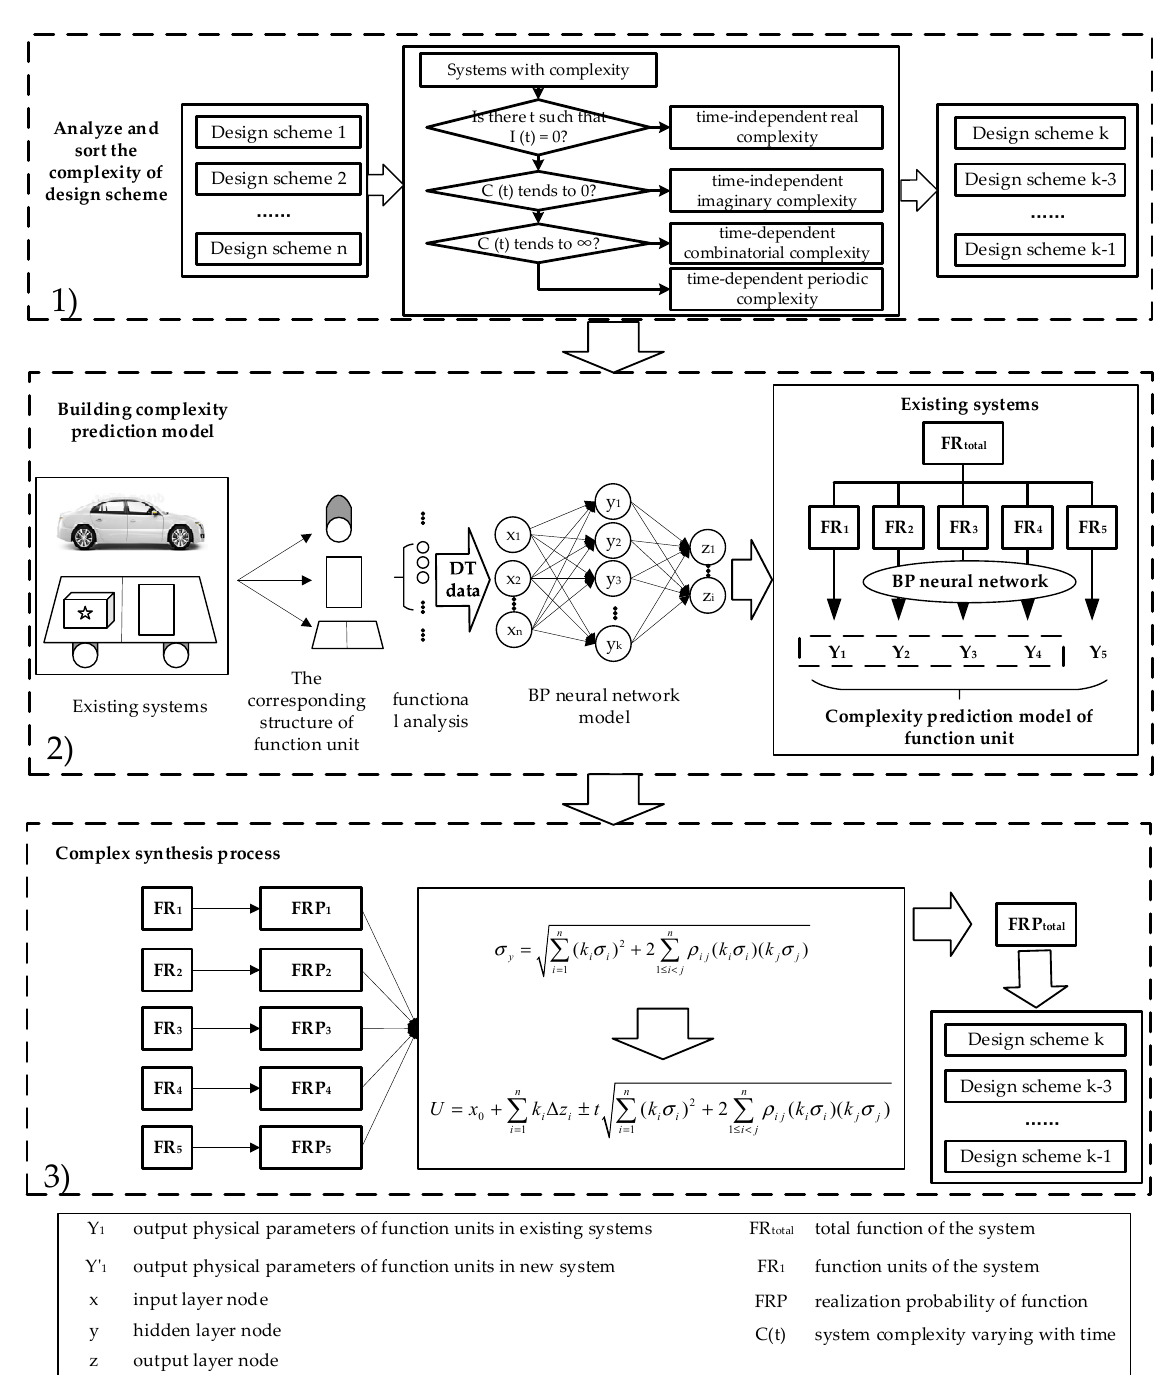
Figure 10. The design-centric complexity composite model.